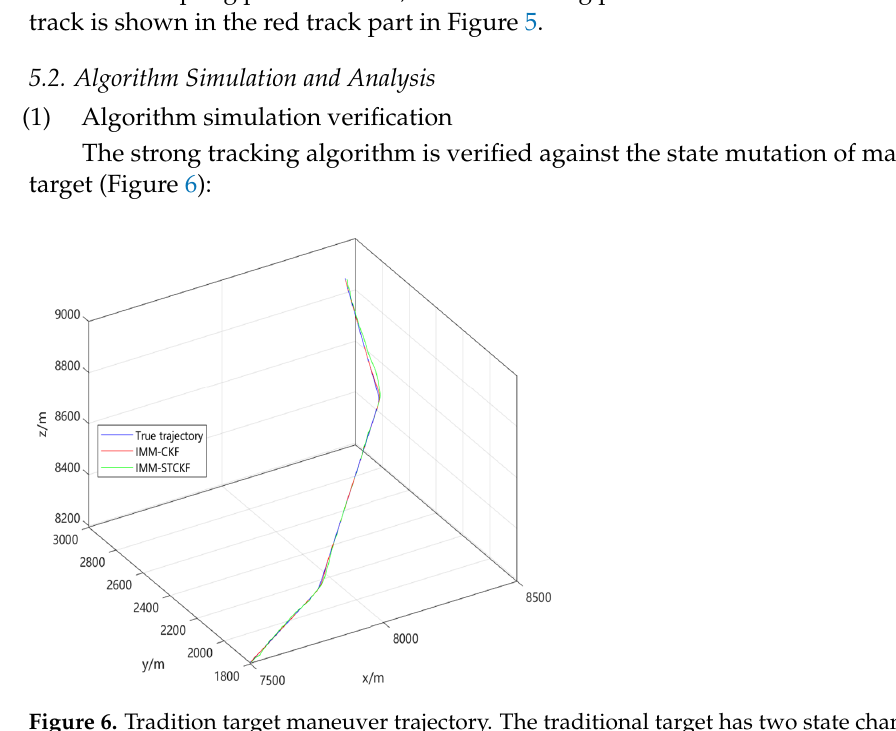
Figure 5. HTV-2 trajectory. The blue track part shows the entire movement process of the hype-sonic target in a step jump process, and the red track part shows the radar observation period. (2) Radar simulation condition setting The coordinates in the radar longitude, latitude, altitude coordinate system were (37.45 , 15 ,0 m) ° − °